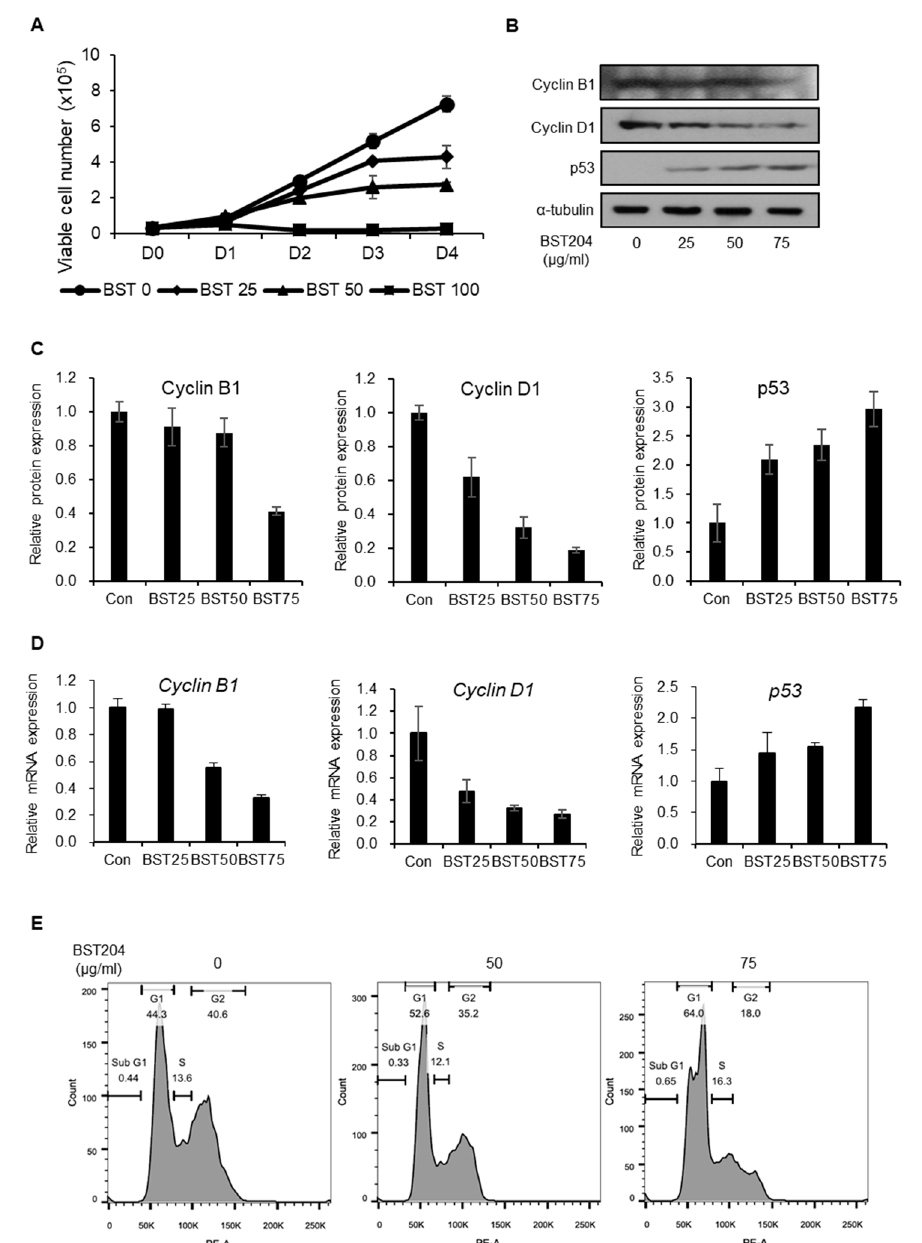
Figure 1. Effect of BST204 on embryonic carcinoma (EC) cell proliferation and cell cycle. ( A ) Proliferation assay of NCCIT cells. Cells were treated with the designated concentrations of BST204 for 4 days. The viable cell number was measured using a trypan blue exclusion assay. ( B ) Expression of cyclin B1, cyclin D1, and p53 was analyzed by immunoblotting. Alpha-tubulin was used as an internal control. ( C ) Relative expression of each protein was analyzed. ( D ) The mRNA levels of cyclin B1, cyclin D1, and p53 were analyzed by RT-qPCR. ( E ) NCCIT cells were treated with BST204, and cell cycle analysis was performed using flow cytometry.